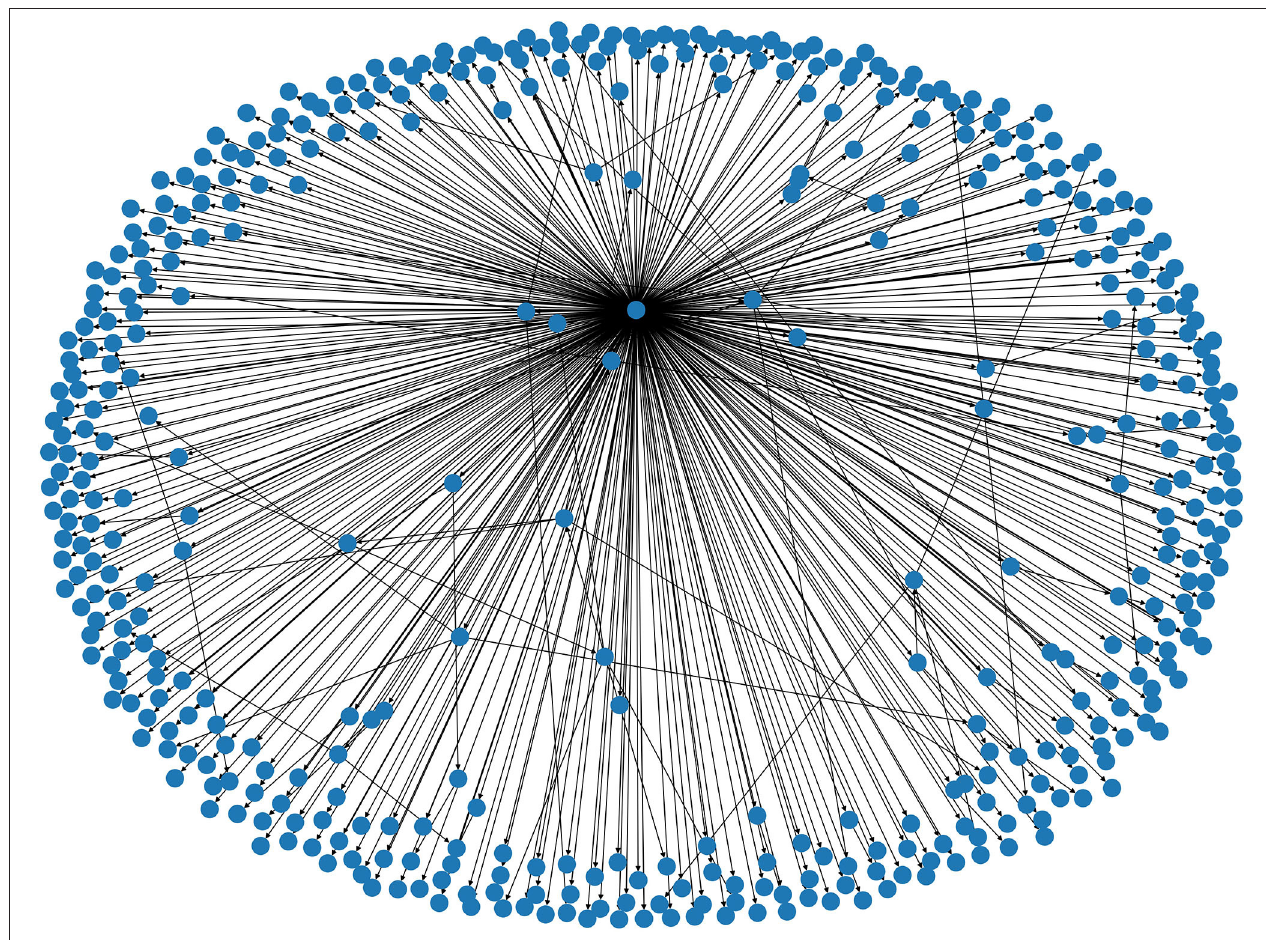
FIGURE 3 | Graph of false story cascade from the Twitter16